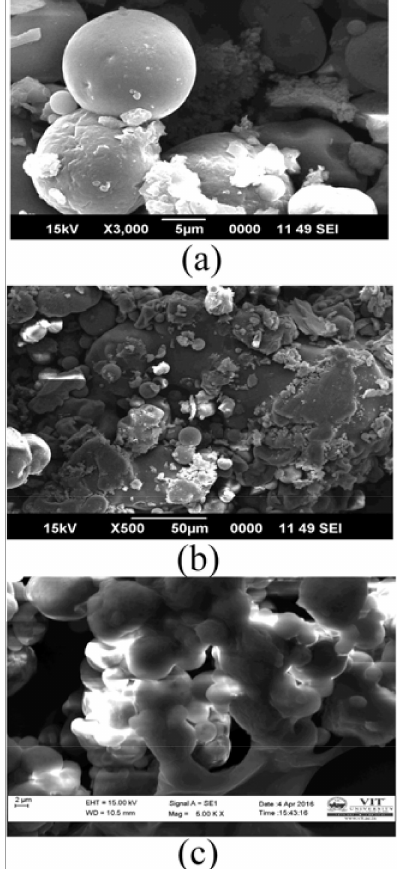
Figure 3. Influence of moisture content on morphology of basundi mix ( a ) at 3% moisture content (3000 × ), ( b ) at 9% moisture content (500 × ) and ( c ) at 9% moisture content (5000 × ) (Mitra et al. [61], with